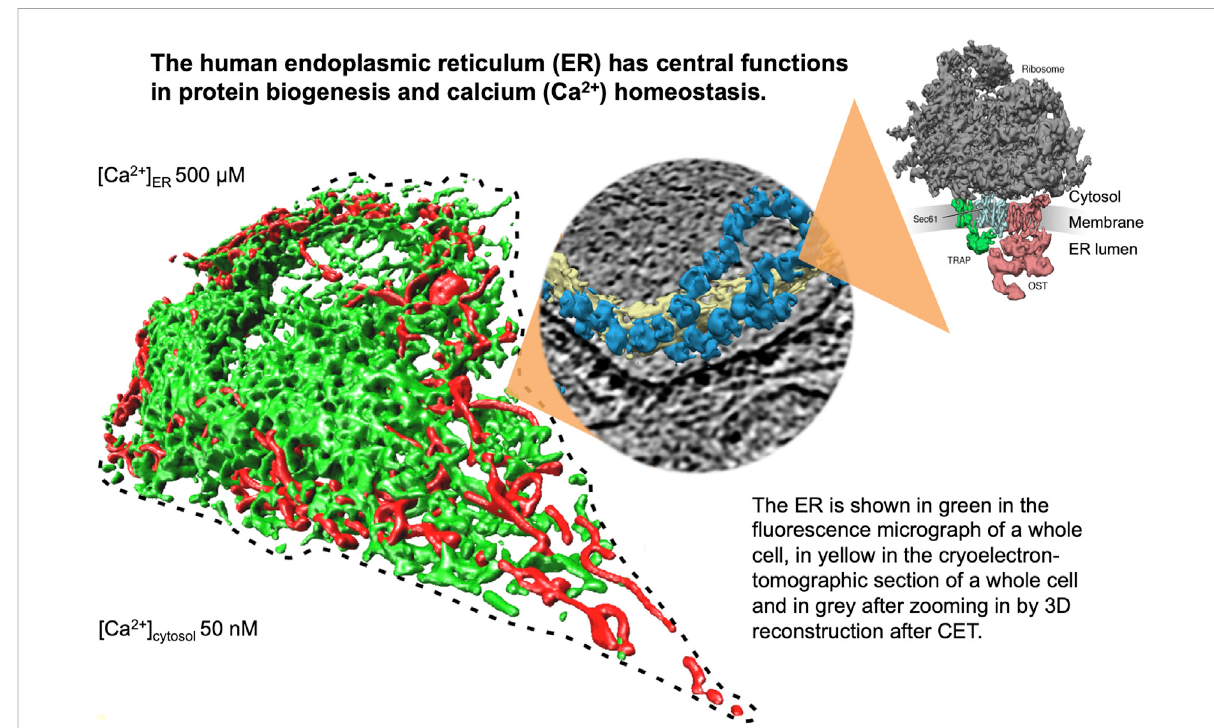
FIGURE 1 The endoplasmic reticulum (ER) of nucleated human cells has major functions in cellular calcium homeostasis, signal transduction and protein biogenesis. Going from left to right, it is shown here after fl uorescence microscopy following expression of a GFP-targeted ER protein and a RFP- targeted mitochondrial protein, after cryoelectron tomography of a HeLa cell, and after 3D reconstruction of the human Sec61 complex together with its interaction partners ribosome, TRAP and oligosaccharyltransferase (Pfeffer et al., 2015). The Figure and Figure legend were adapted from Sicking et al.